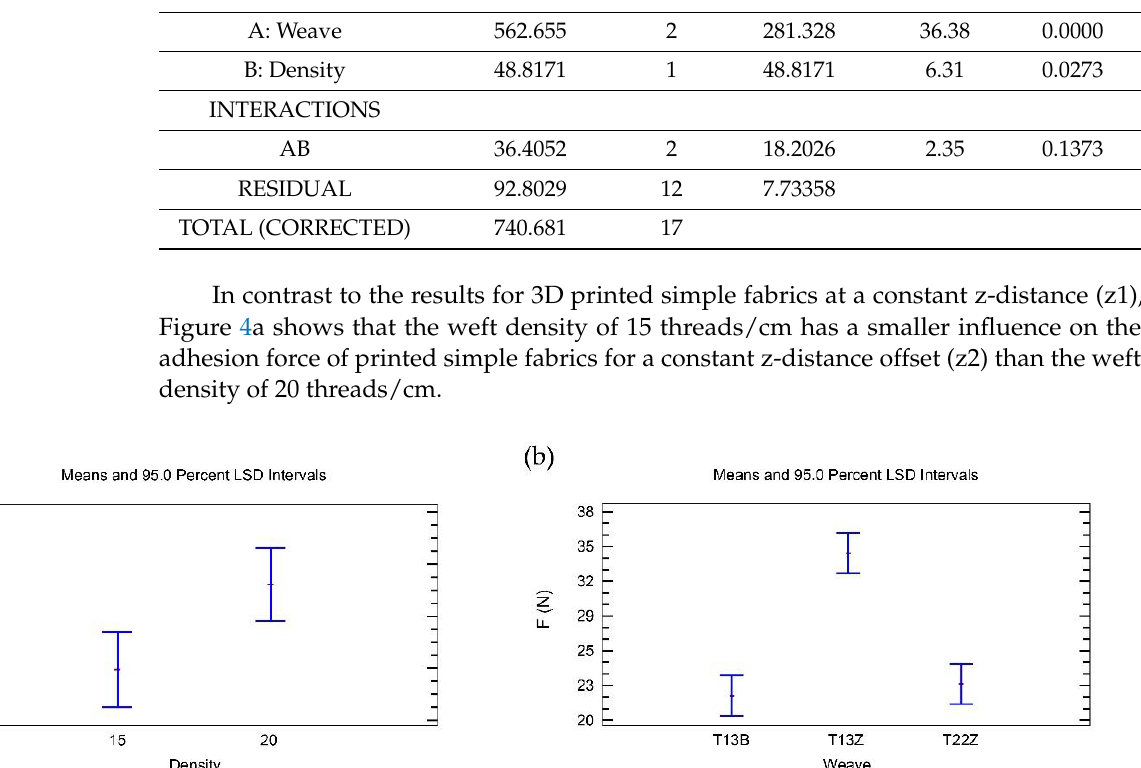
Table 7. Impact of weave and density on the adhesion force for simple fabrics for z2.